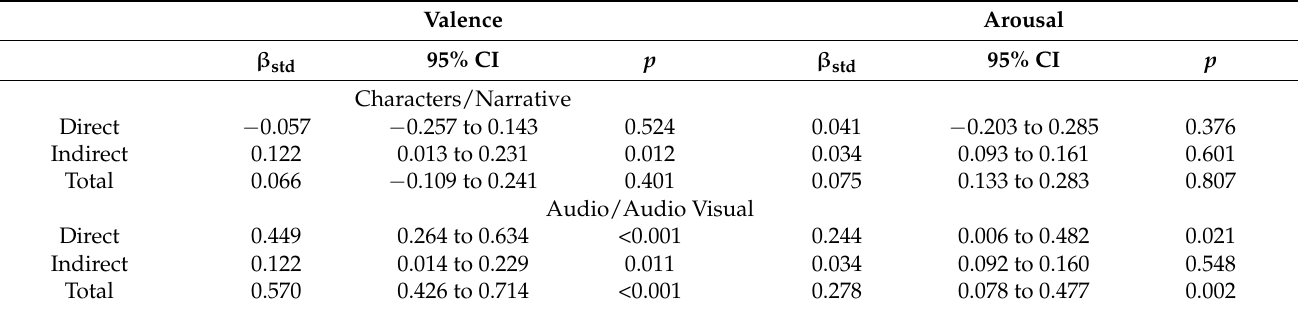
Table 3. Structural Equation Modelling